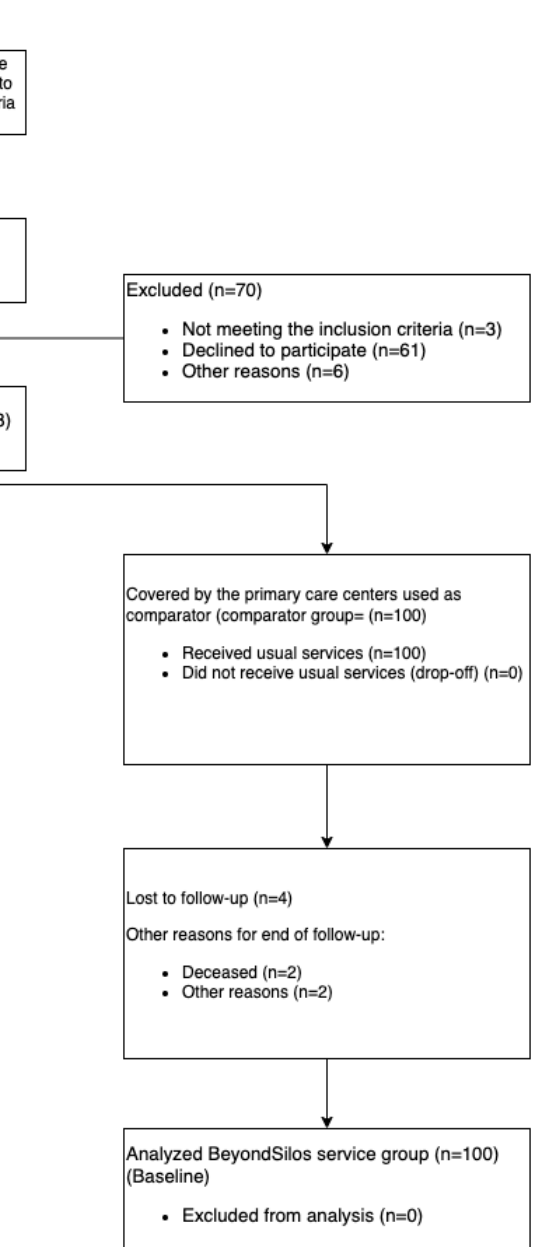
Table 1 summarizes the sociodemographic characteristics of study participants. Participants in the 2 study groups were balanced regarding education level and household income, but